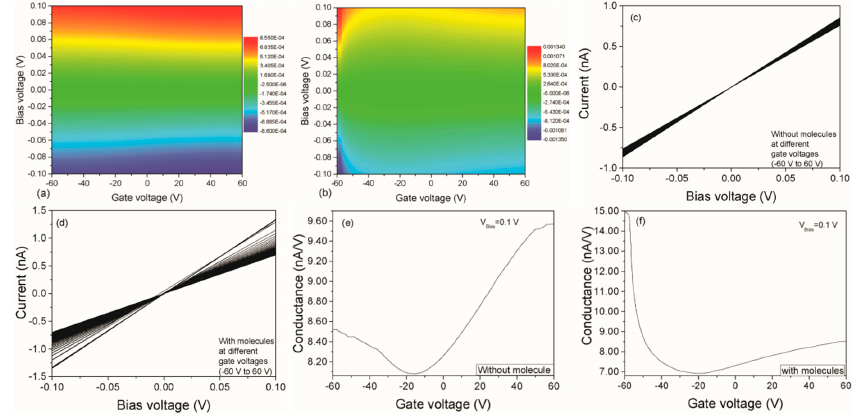
Figure 8. Gate- and bias-voltage-dependent electrical current for a device without ( a ) and with ( b ) addition of molecules; ( c , d ) the current varies with bias voltage at different gate voltages; ( e , f ) gate-voltage-dependent conductance for a device without and with molecules, where V Bias = 0.1 V [69]. Copyright 2017,